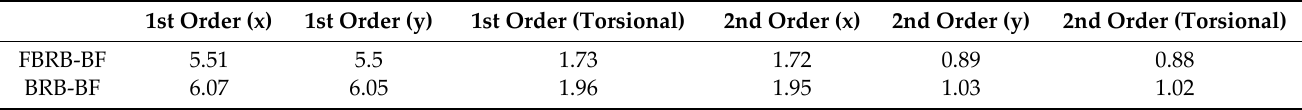
Table 6. Periods information for FBRB‑BF and BRB‑BF.